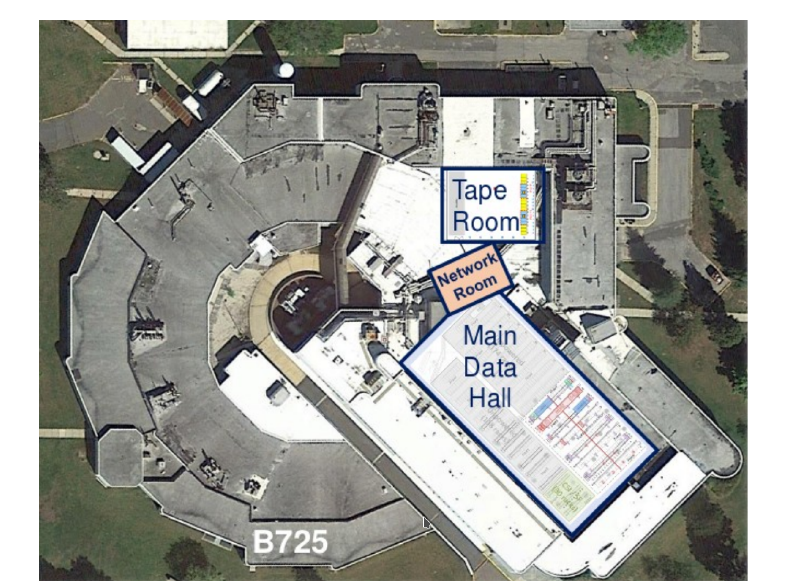
Figure 1. New Data Center - Layout within former NSLS